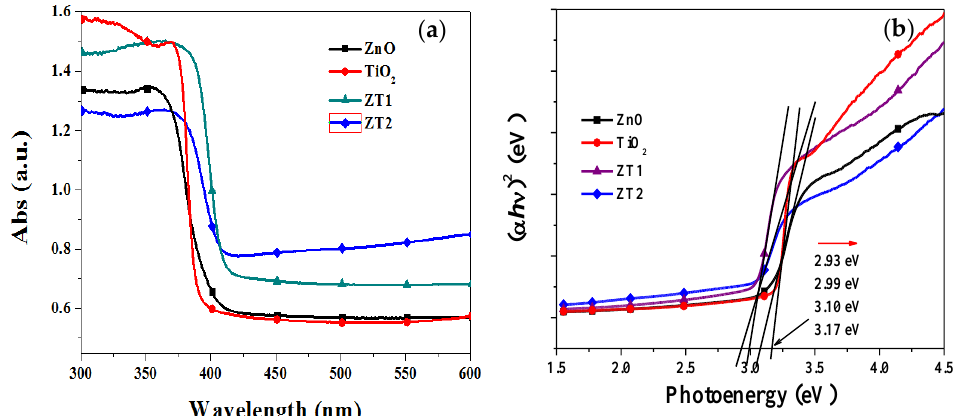
Figure 4. ( a ) UV-Vis absorption spectra, ( b ) plots of ( αhν ) 1/2 vs. photoenergy of TiO 2 , ZnO, and ZnO/TiO 2 heterojunction films measured at room temperature.